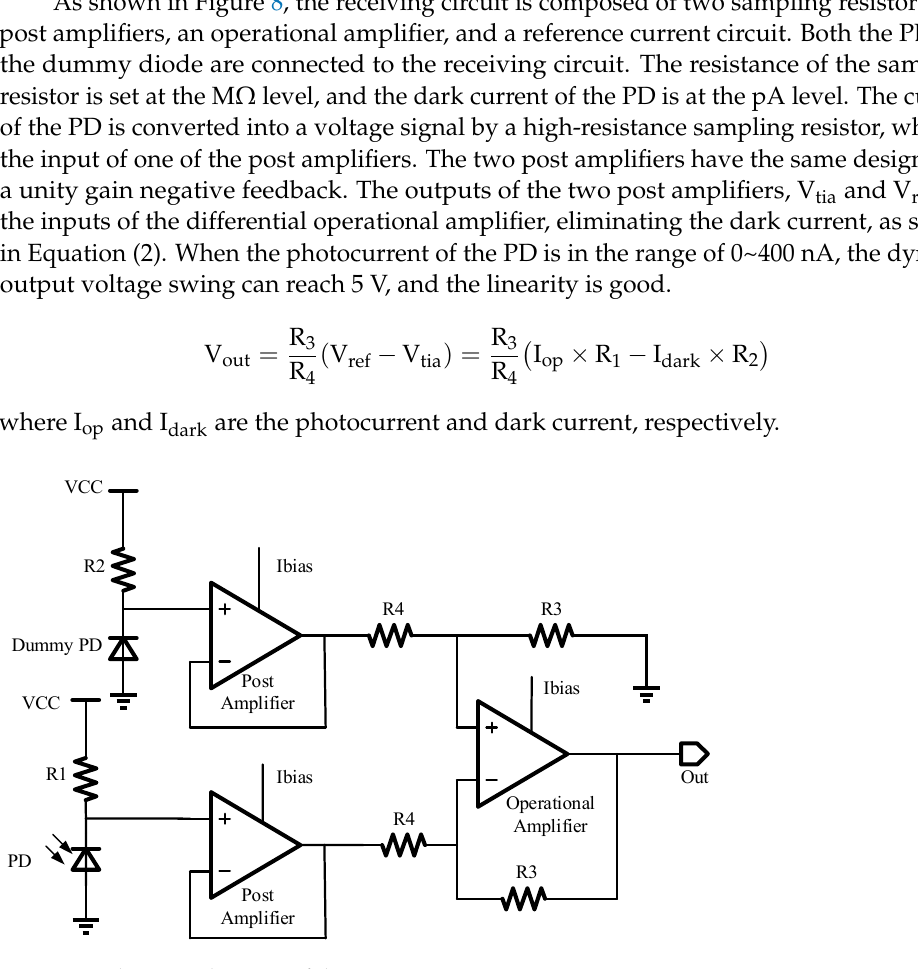
Figure 7. Simulated spectral response curve of the PD.